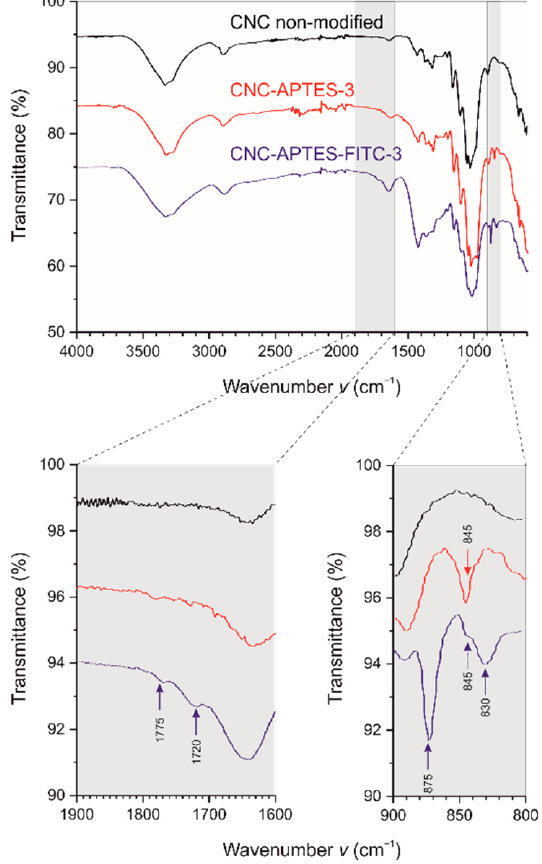
Figure 3. IR-spectra of CNC non-modified, CNC-APTES-3 and CNC-APTES-FITC-3. Furthermore, photometric spectra of CNCs and CNC-APTES-FITC-3 were recorded in transmission (dry films on glass plates) as shown in Figure S6. The significant peak of the spectrum of CNC-APTES-FITC-3 in the region between 450 and 530 nm has a maximum at 504 nm, which is slightly higher than the photometric absorption maximum of molecular FITC at 495 nm. The formation of the thioester presumably modulates the excitation energy of the entire dye molecule, leading to lower excitation energies, related to higher absorption wavelengths. respectively); see Table 2. Grafting at higher pH levels (CNC-APTES-1 and CNC-APTES-2) results in virtually higher DoS, probably due to precipitation of APTES. Exemplarily for CNC-APTES-3, the DoS surface according to Equation (1) (see Section 2.2.5) would be 0.058, which means that almost every 17th superficial AGU is grafted with a silane molecule, or every 50th exposed hydroxy group is